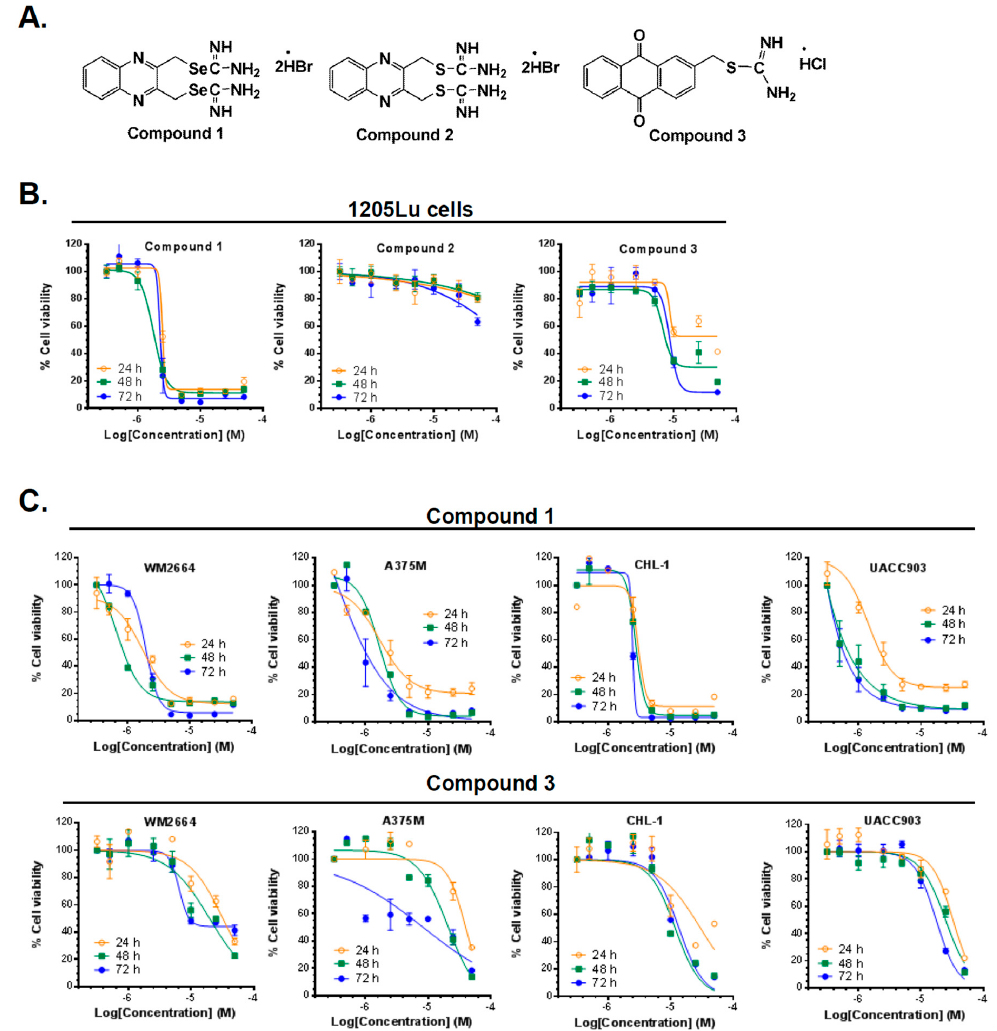
Figure 1. Compounds 1 and 3 were effective at reducing cell viability of different melanoma cancer cell lines. ( A ) Structures of the compounds, ( B ) Screening of the three agents in melanoma cells (1205Lu) for 24, 48, and 72 h using the MTT (cell viability) assay ( C ) Cell viability (MTT) results for compounds 1 and 3 in four different melanoma cancer cell lines at three different time points. Graphs were obtained by performing non-linear regression analysis using variable slope. Error bars represent mean ± SD.